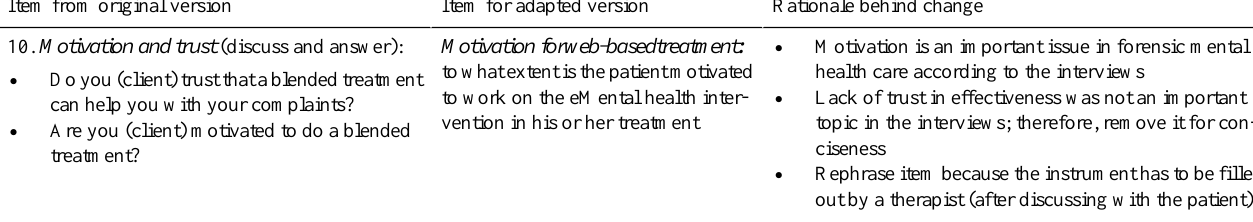
Rationale behind changeItem for adapted versionItem from original version